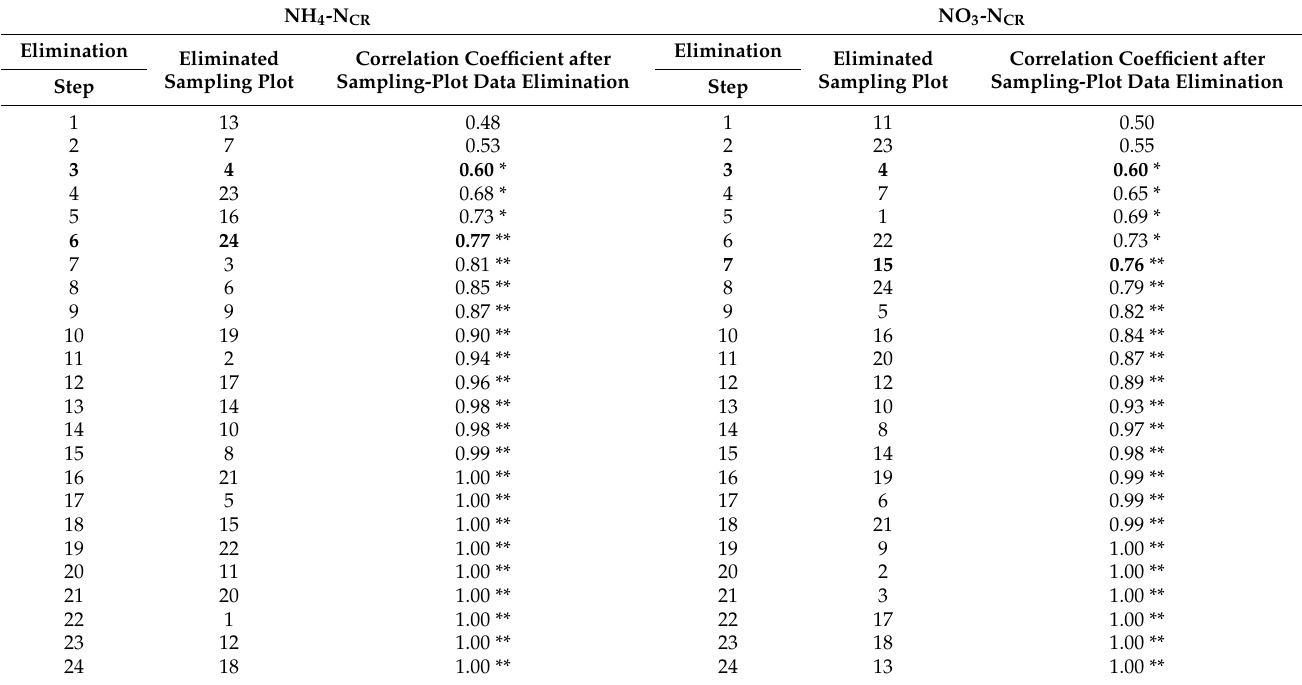
Table 3. Eliminated sampling plots and ERs between TN CR and NH 4 -N CR and ERs between TN CR and NO 3 -N CR after a step-by-step elimination of the